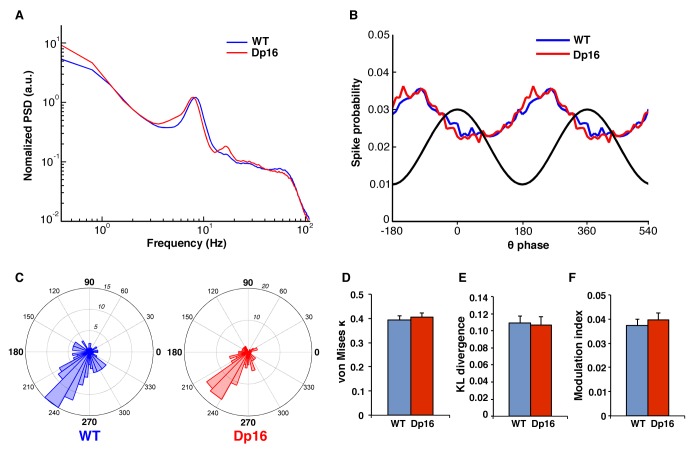
LFP power and phase locking properties of CA1 place cells are conserved in Dp(16)1Yey mice.(A) Power spectrum density (PSD) curves of CA1 local field potentials (LFP) during linear track exploration showed no significant differences between Dp(16)1Yey and WT mice, including in the theta (6–12 Hz), beta (15–30 Hz) and gamma bands (30–100 Hz). (B) The number of spikes plotted as a function of the phase of theta showed a similar pattern between WT and Dp(16)1Yey mice, peaking shortly after the trough of theta (black curve). (C) The preferred firing phase was calculated for significantly theta-modulated neuron during the exploration phase in the linear track and plotted in a circular histogram. No significant differences were observed between Dp(16)1Yey and WT groups, with a preferred phase of theta around 215–240° (0/360° set for theta peak, 180° for theta trough). (D) The von Mises κ parameter revealed no significant differences in the concentration of firings across the theta cycle between Dp(16)1Yey and WT. No group differences where observed in average pyramidal cell Kullback-Leibler divergence (E) and modulation index (F). Values are expressed as mean ±standard error of the mean. Statistical significance was assessed using ANOVA for repeated measures (A), circular ANOVA (B), Kuiper test (C) or Mann-Whitney U-test (D–F) with significance set at p<0.05.